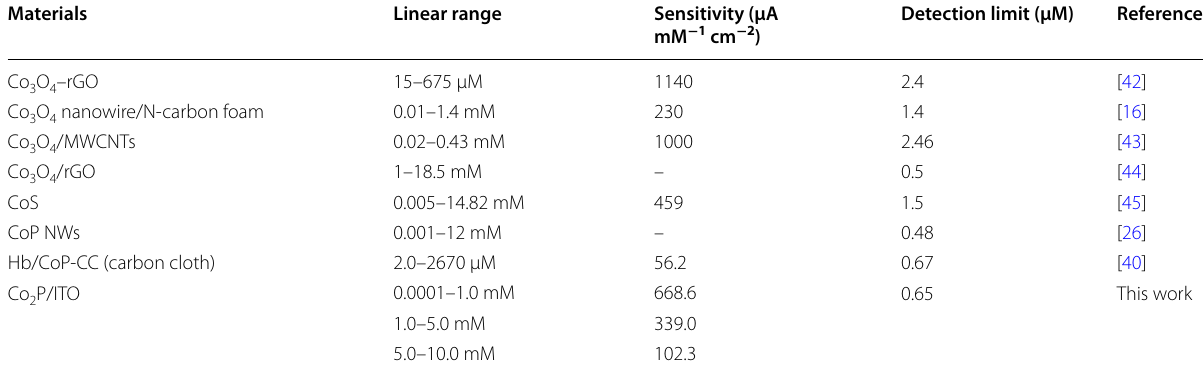
P/ITO with other cobalt-based non-enzymatic H 2